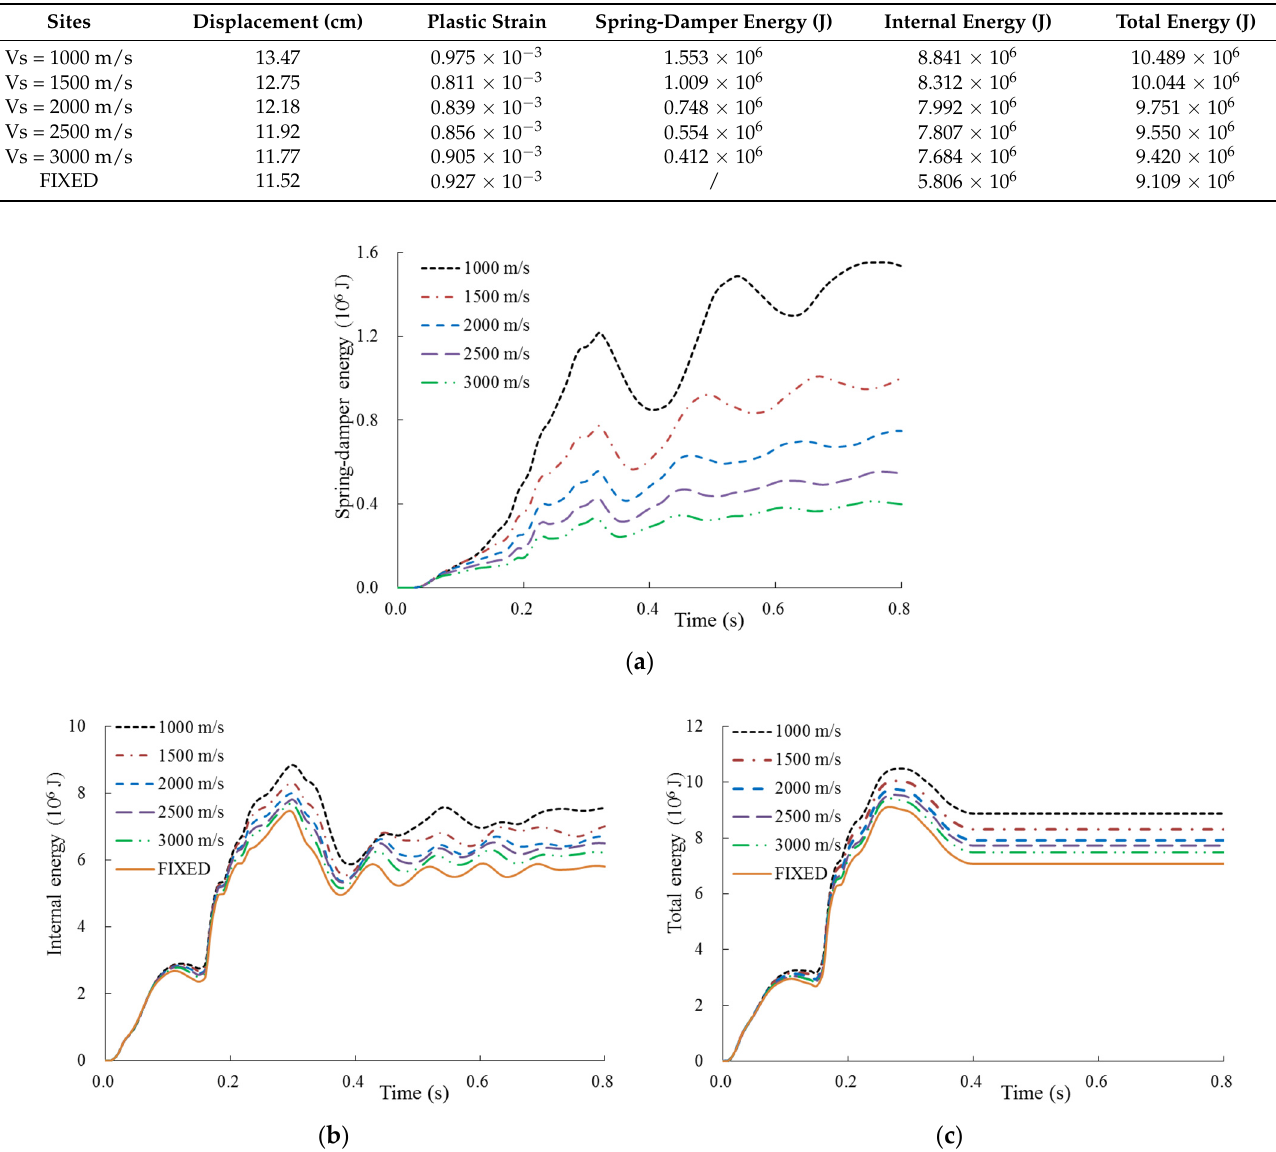
Figure 12. The spring-damper energy, internal energy, and total energy of containment for different site conditions. ( a ) Spring-damper energy. ( b ) Internal energy. ( c ) Total